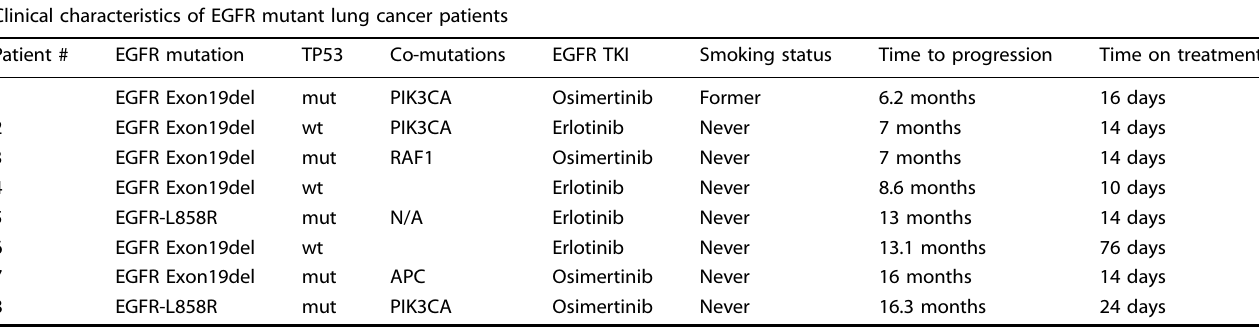
Table 1. EGFR mutant lung cancer patients diagnosed at the University of Colorado Hospital and the University of California San Francisco were consented to an IRB-approved protocol to obtain tumor biopsies before and after 2 weeks of treatment with the indicated TKI. Clinical characteristics of EGFR mutant lung cancer